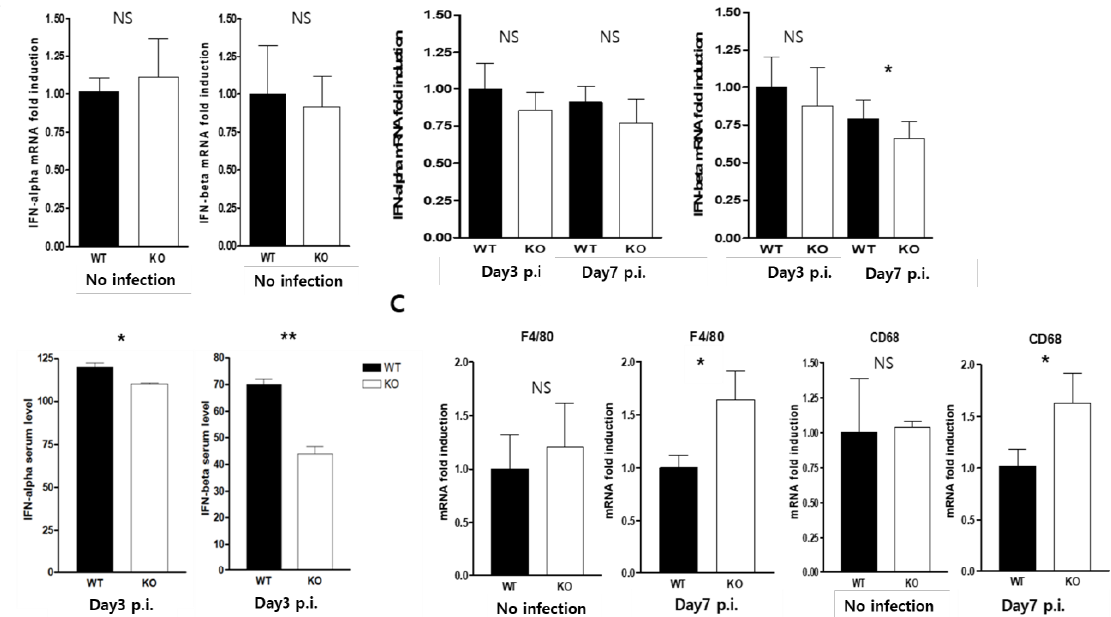
Figure 5. CAR deletion suppressed the serum levels of type 1 interferon levels in CVB3 infection. ( A , C ) Total RNA was extracted from WT and KO mice hearts at day three and seven p.i, and then subjected to real-time PCR with the indicated primer sets. ( B ) The serum levels of IFN- α and IFN- β were measured using the ELISA system. All data are expressed as the mean ± SEM. NS, not significant, * p < 0.05 and ** p < 0.01 according to a two-tailed Student’s t -test.